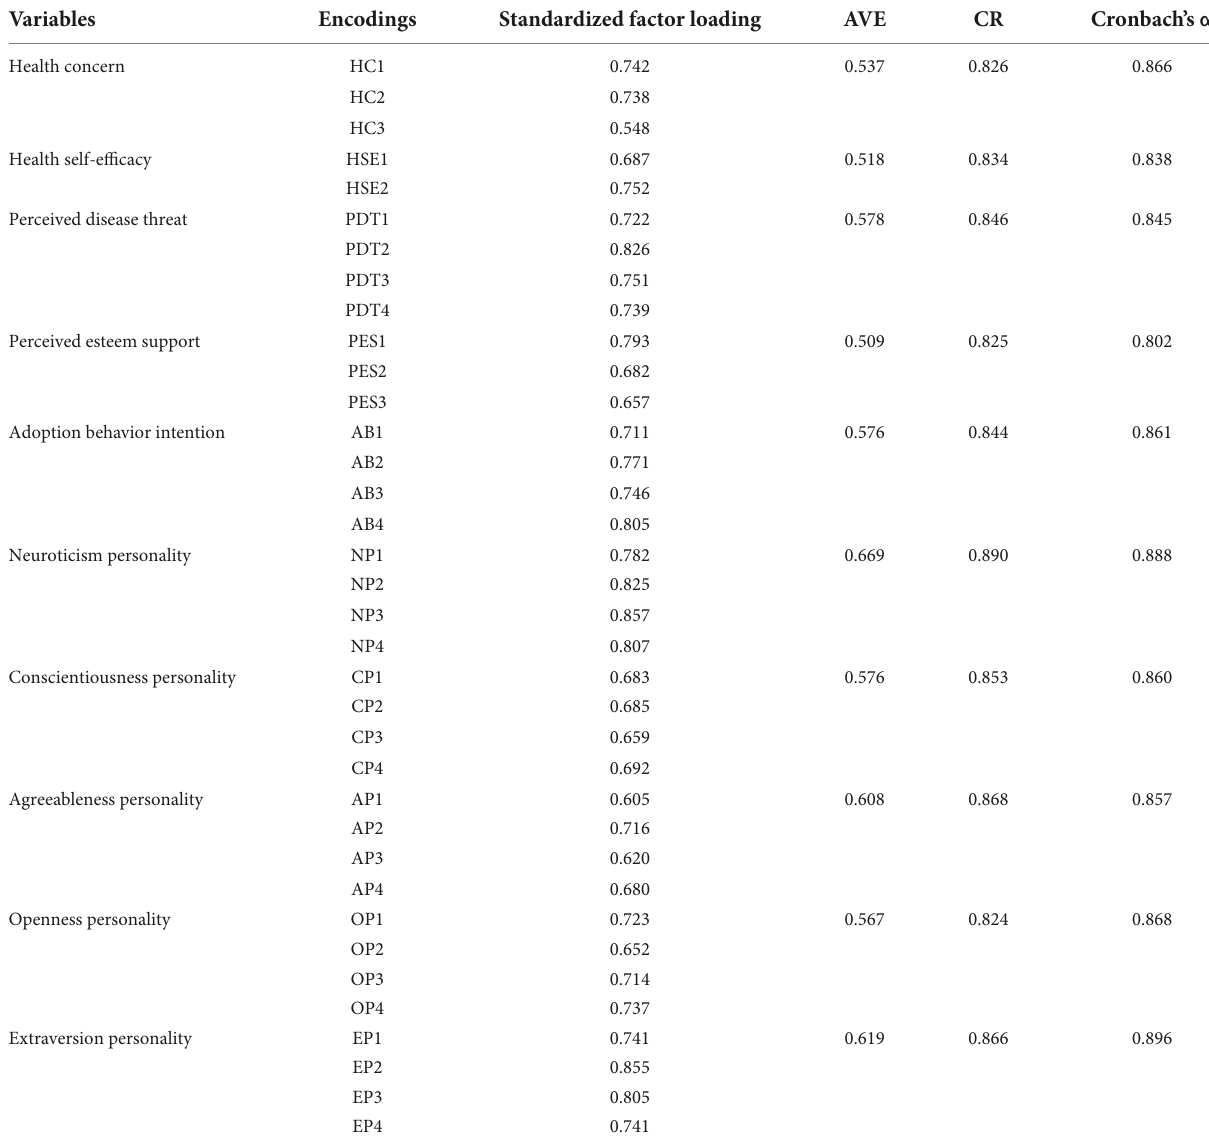
TABLE 3 AVE and CR values for model